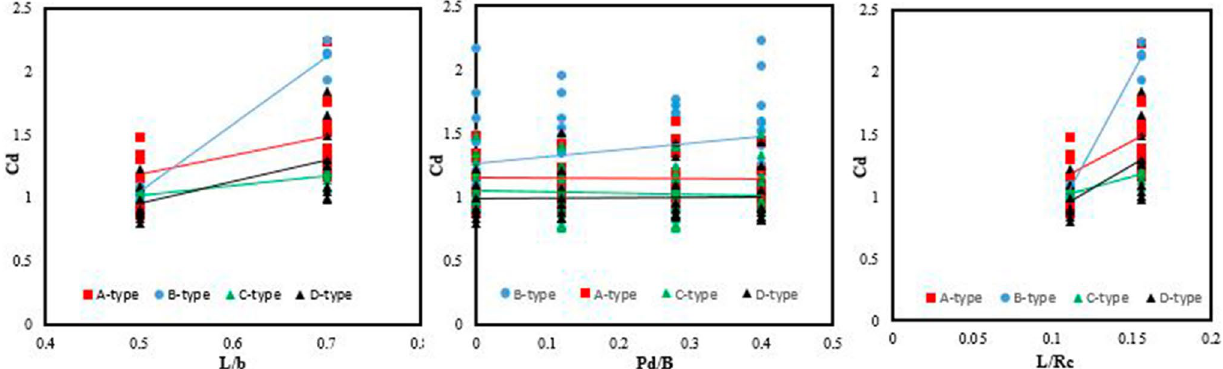
Fig. 11 Variations of discharge coefficient of piano key weir versus L / b , P